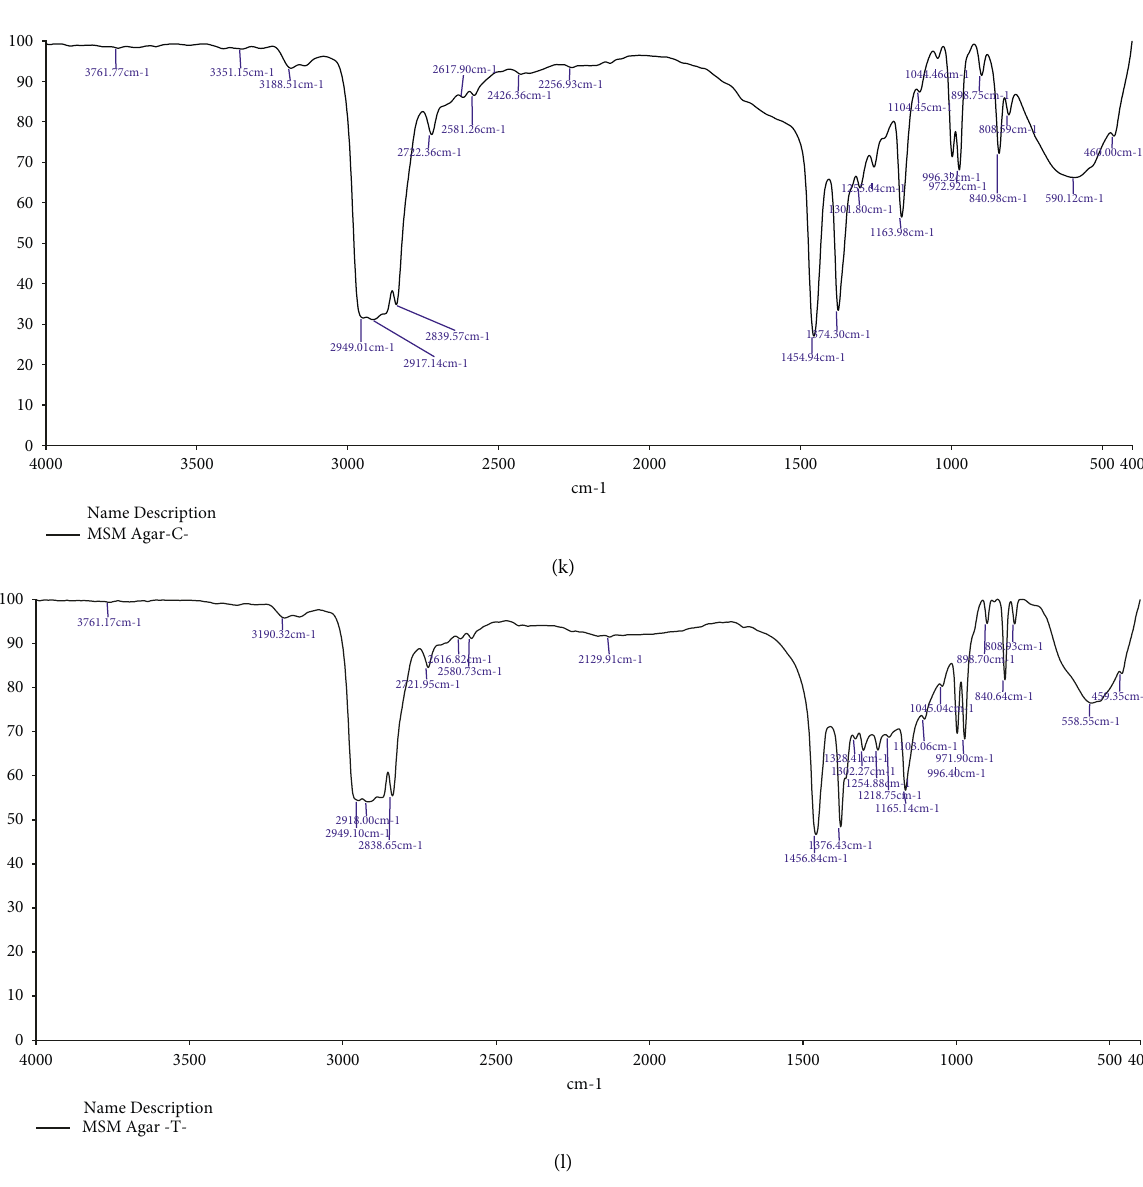
Figure 4: (a) IR spectra of PP films in NB (control). (b) IR spectra of PP films in NB (treated). (c) IR spectra of PP films in NA (control). (d) IR spectra of PP films in NA (treated). (e) IR spectra of PP films in BHM broth (control). (f) IR spectra of PP films in BHM broth (treated). (g) IR spectra of PP films in BHM agar (control). (h) IR spectra of PP films in BHM agar (treated). (i) IR spectra of PP films in MSM broth (control). (j) IR spectra of PP films in MSM broth (treated). (k) IR spectra of PP films in MSM agar (control). (l) IR spectra of PP films in MSM agar